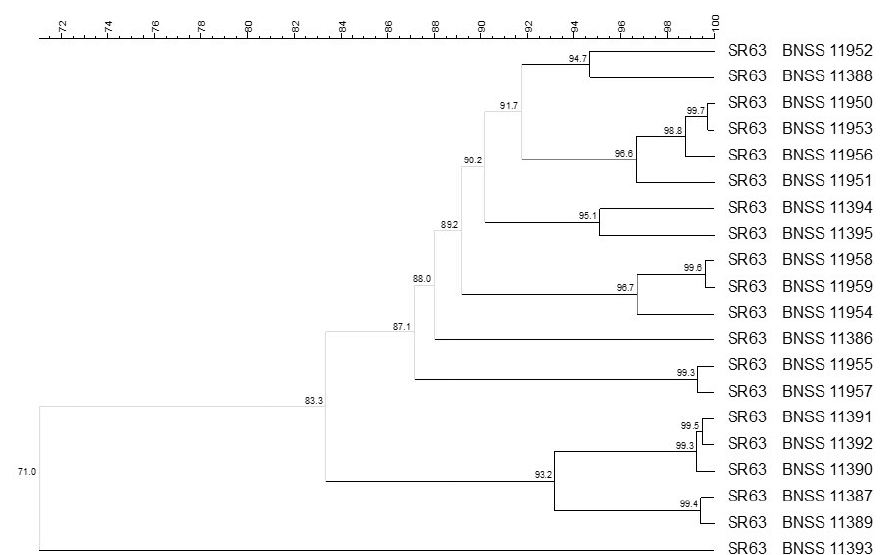
Figure 6. UPGMA cluster analysis, using Pearson correlation, of (GTG) 5 rep-PCR and PFGE elaborated by composite data set comparison tool, of 20 Limosilactobacillus reuteri isolates from SR63 natural cultures For each isolate, the indication of the culture and the BNSS ID were reported.